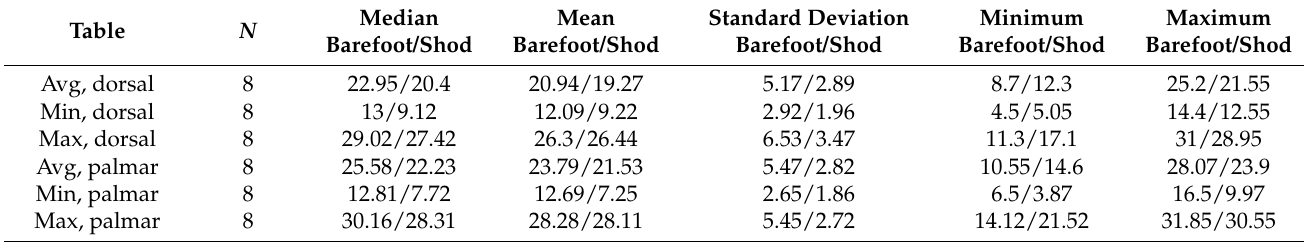
Table 2. Thermographic results received from group 2 before and after shoeing with wedge pads. Avg, average temperature; Min, minimum temperature; Max, maximum